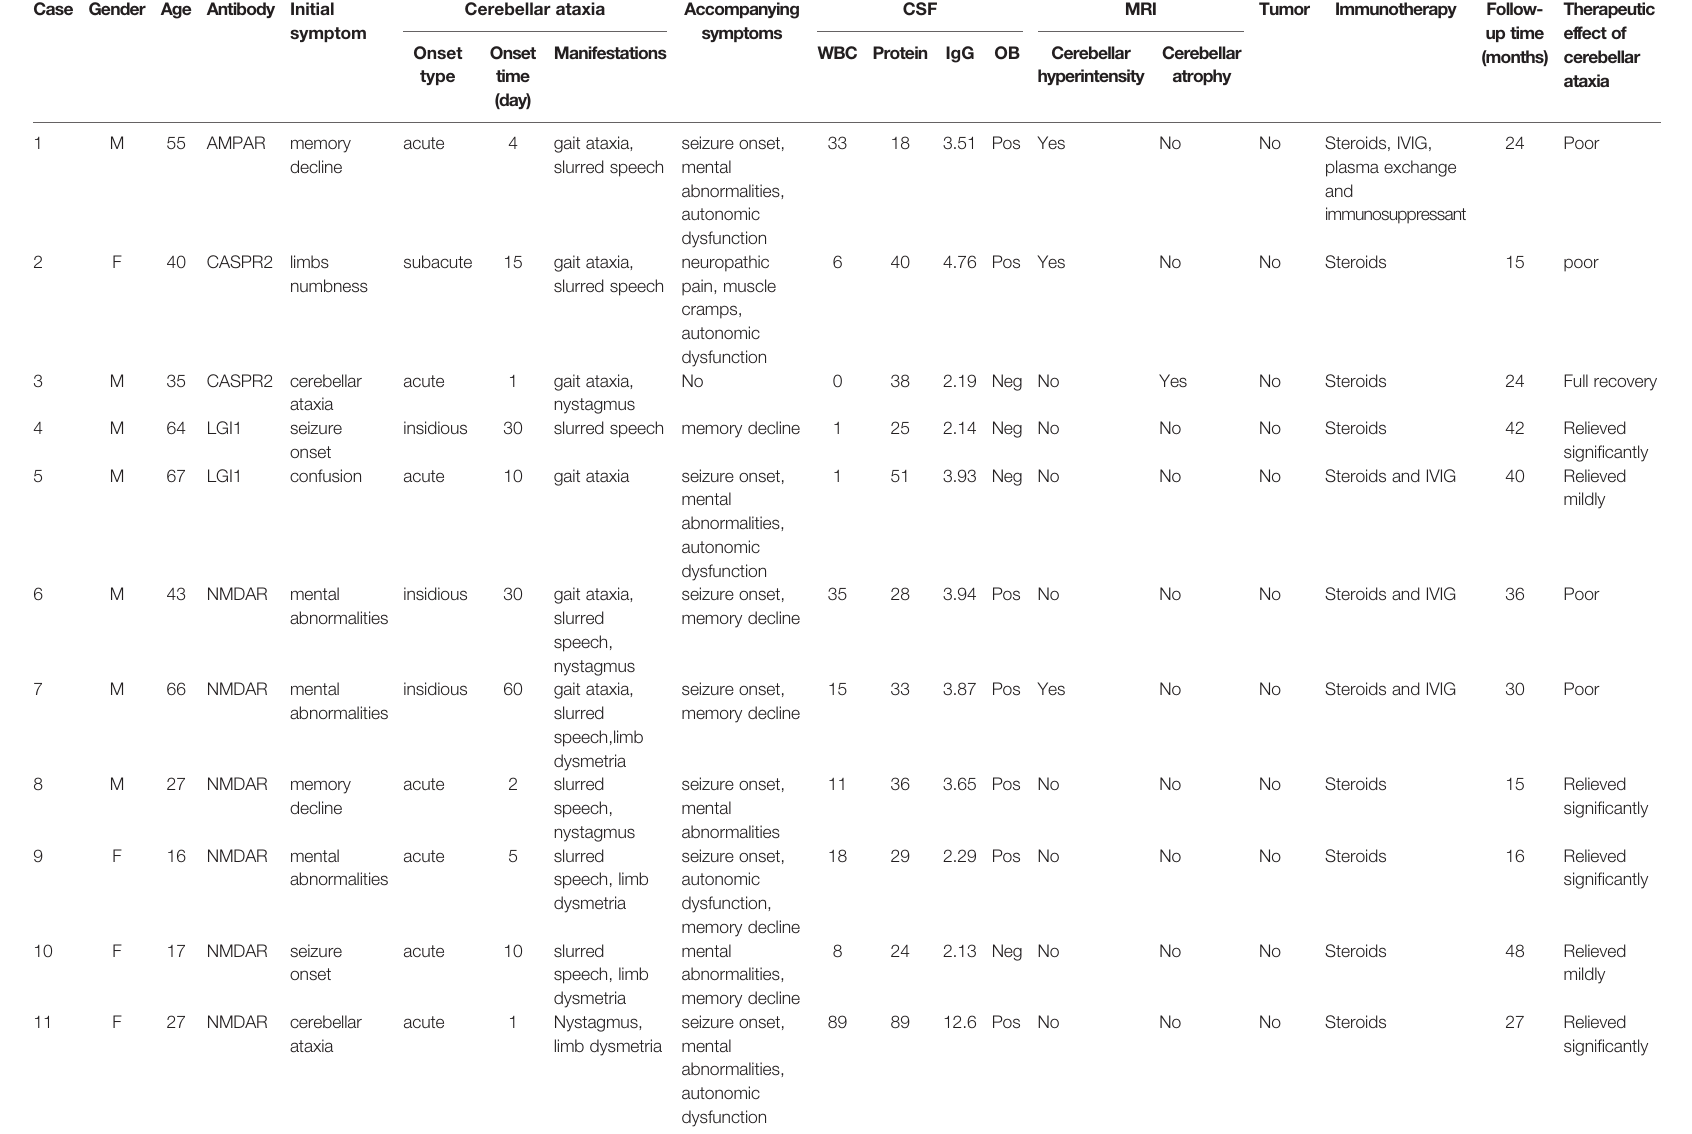
TABLE 4 | Clinical characteristics of patients with anti-NSAbs-associated CAs. Case Gender Age Antibody Initial